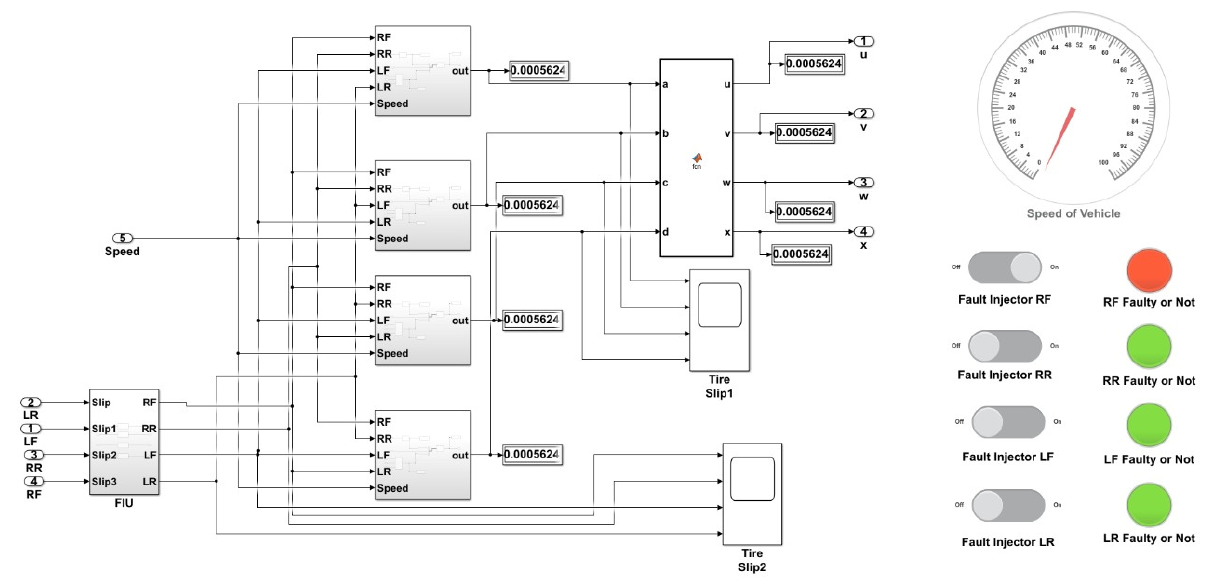
Figure 4. Active fault-tolerant controller applied on the autonomous vehicle.